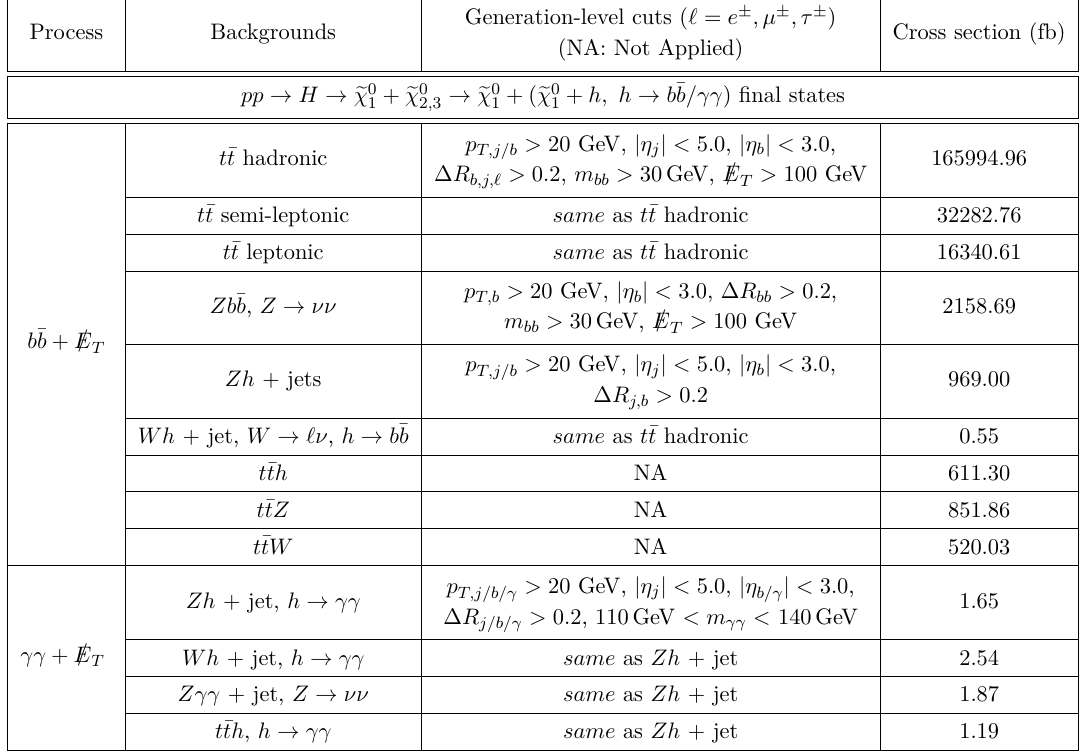
Table 37. Generation level cuts and cross-sections for the various Standard Model backgrounds used in the